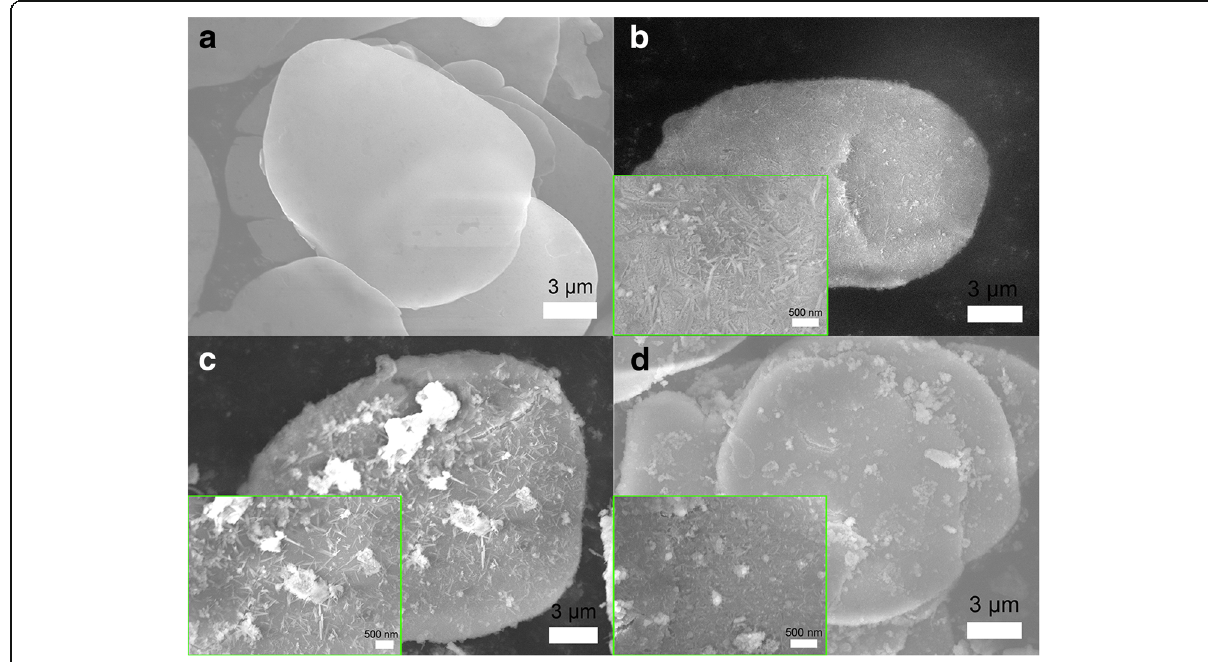
Fig. 2 The SEM micrographs of the Al/MnO 2 composite pigments with a aluminum flake, b S2, c S3, and d S4